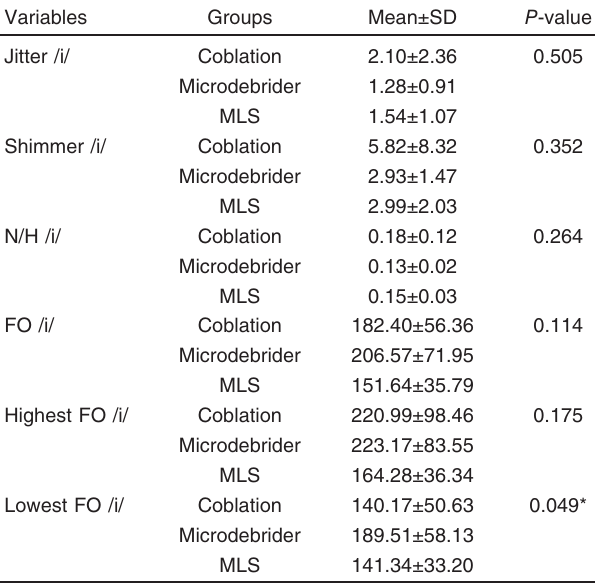
Table 13 Comparison between groups of the study regarding different variables after intervention /i/